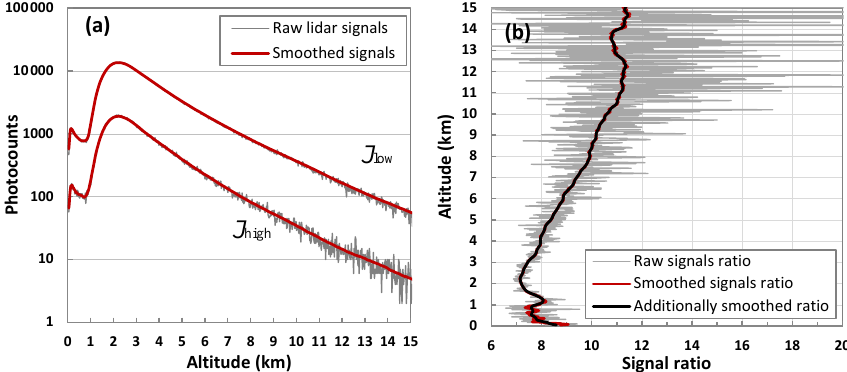
Figure 11. IMCES lidar data taken between 20:21 and 21:21LT on 2 October 2014 (13:21–14:21UTC). (a) Raw photocounts N L and N H detected in the lidar channels with J low and J high , respectively, together with the single-averaged ones N L and N H . (b) Raw photocounts ratio Q = N L / N H , single-averaged photocounts ratio Q = N L /N H , and additionally averaged ratio Q I = Q = N L /N H .